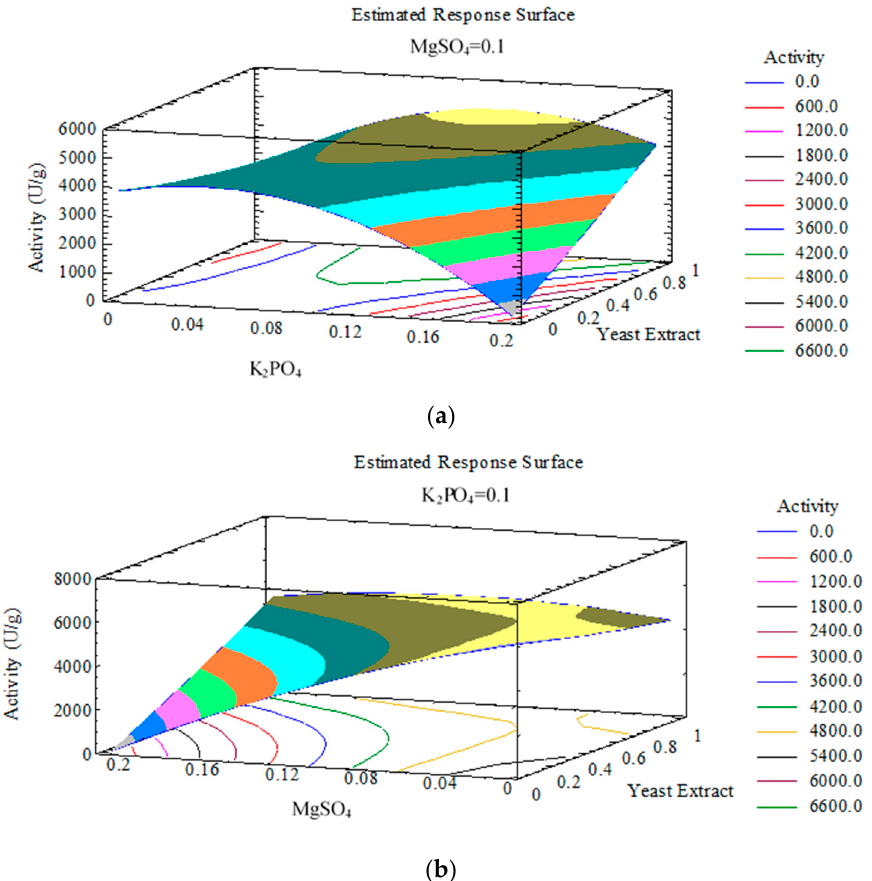
Figure 2. Response surface plots representing the effect of independent variables on xylanase activity: ( a ) The effect of KH 2 PO 4 and yeast extract on xylanase activity when response surface is fixed at MgSO 4 = 0.1 g/g of spent coffee waste (SCW); ( b ) the effect of MgSO 4 and yeast extract on xylanase activity when response surface is fixed at KH 2 PO 4 = 0.1 g/g of SCW. Table 9. Purification of xylanase from A. niger.